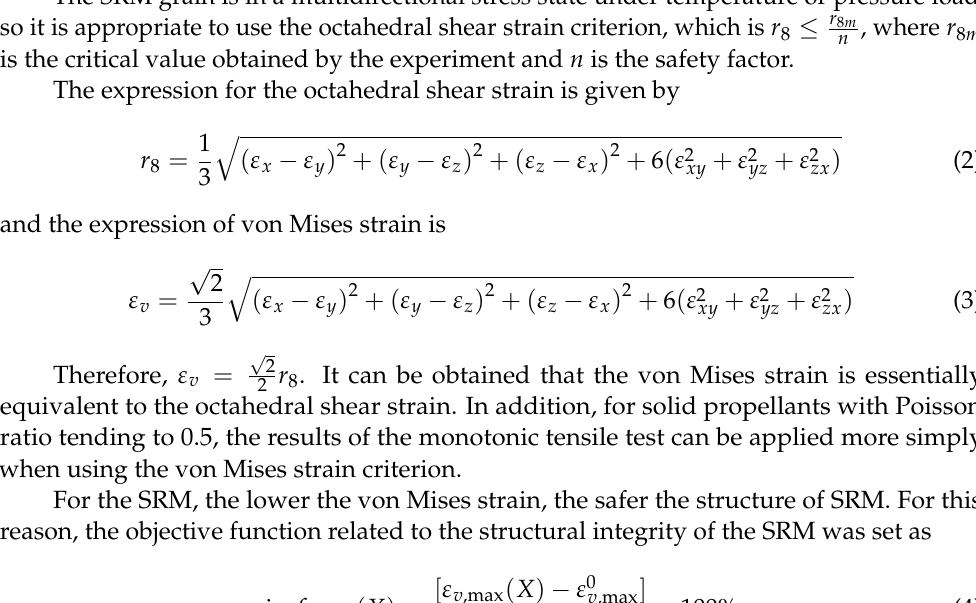
Figure 3. Schematic diagram of the life and load history of SRM.